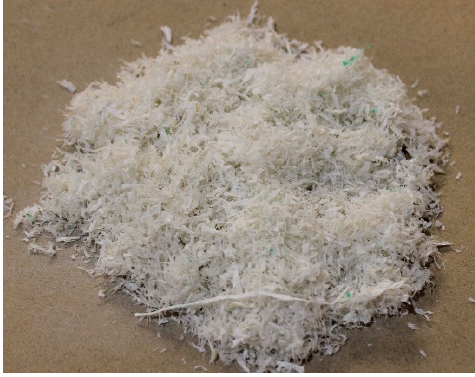
Figure 2. Shredded polypropylene bags.